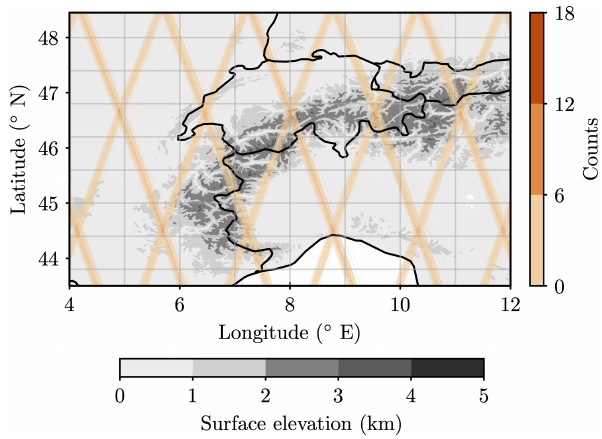
Figure 2. Geographical distribution of the satellite observations: number of tracks through each point within the study domain (43.5 to 48.5 ◦ N and 4 to 12 ◦ E ) over the whole time period analysed in this study